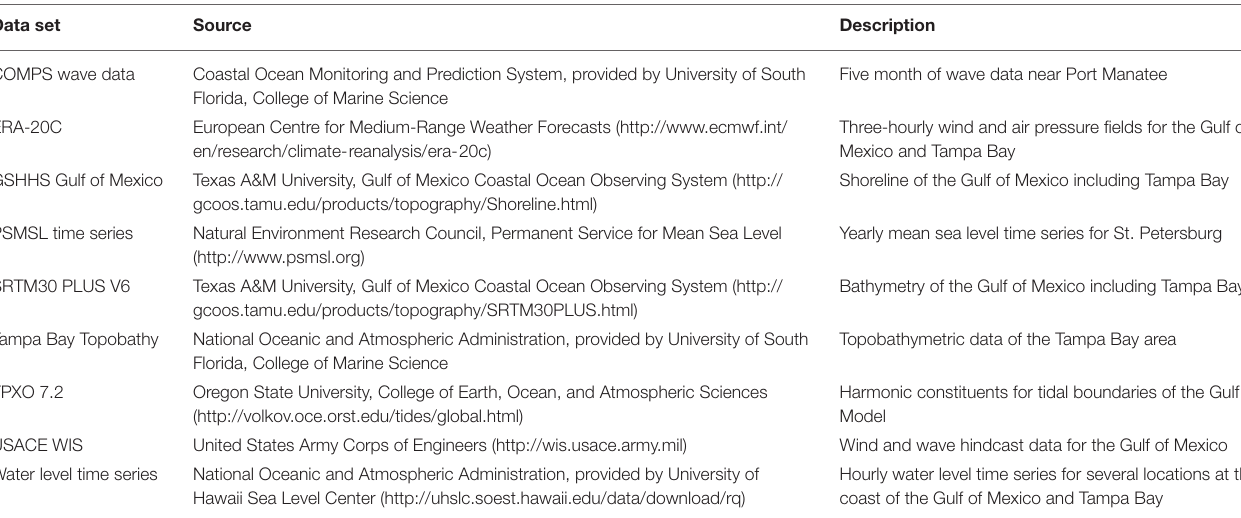
TABLE 1 | Data sets and data sources used for the study.